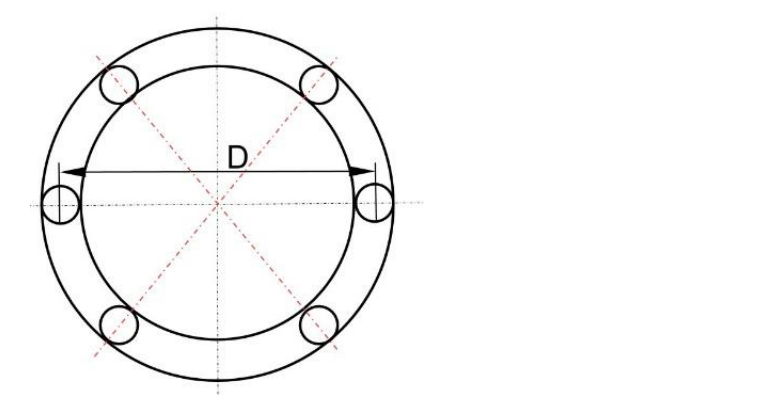
Figure 9. The position of the bullet in the weapon. Table 2. Gatling gun rotation rate. Gatling Gun rpm Speed of Revolution Round/s Rotor Speed